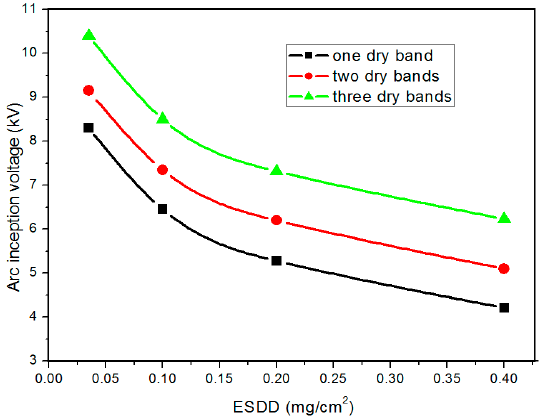
Figure 11. Arc inception voltage at different number of dry bands, where NSDD = 0.75 mg/cm 2 , humidity level = low, temperature = 10 °C, and standard deviation = 2.1%–4.7%.